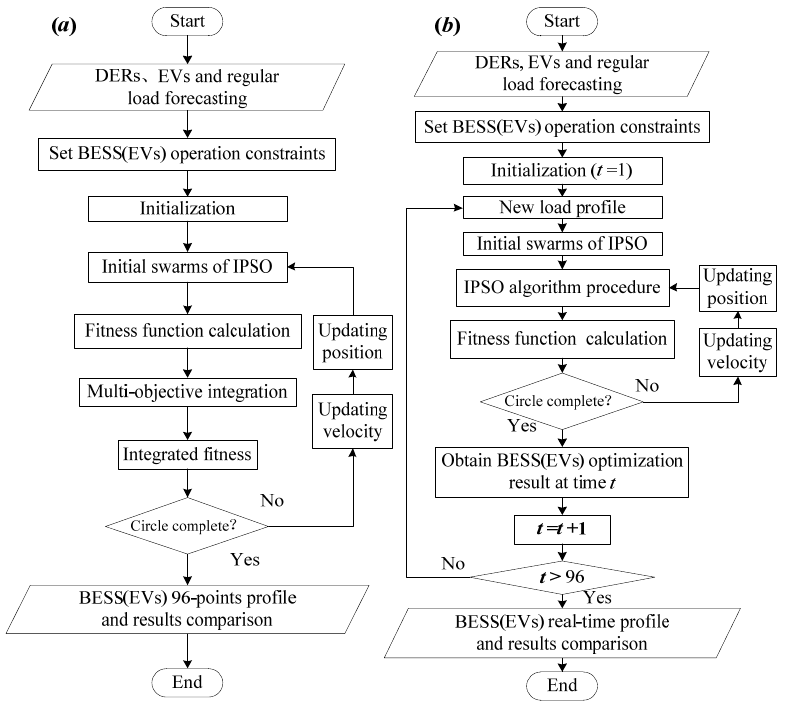
Figure 2. ( a ) Day-ahead strategy flow chart; ( b ) real-time strategy flow